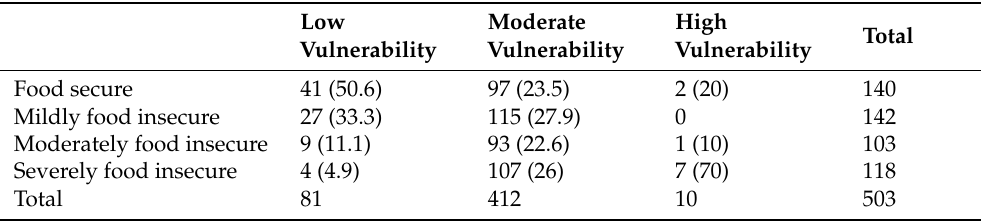
Table 5. Cross tabulation of Farming and Fishing households by vulnerability level and food security